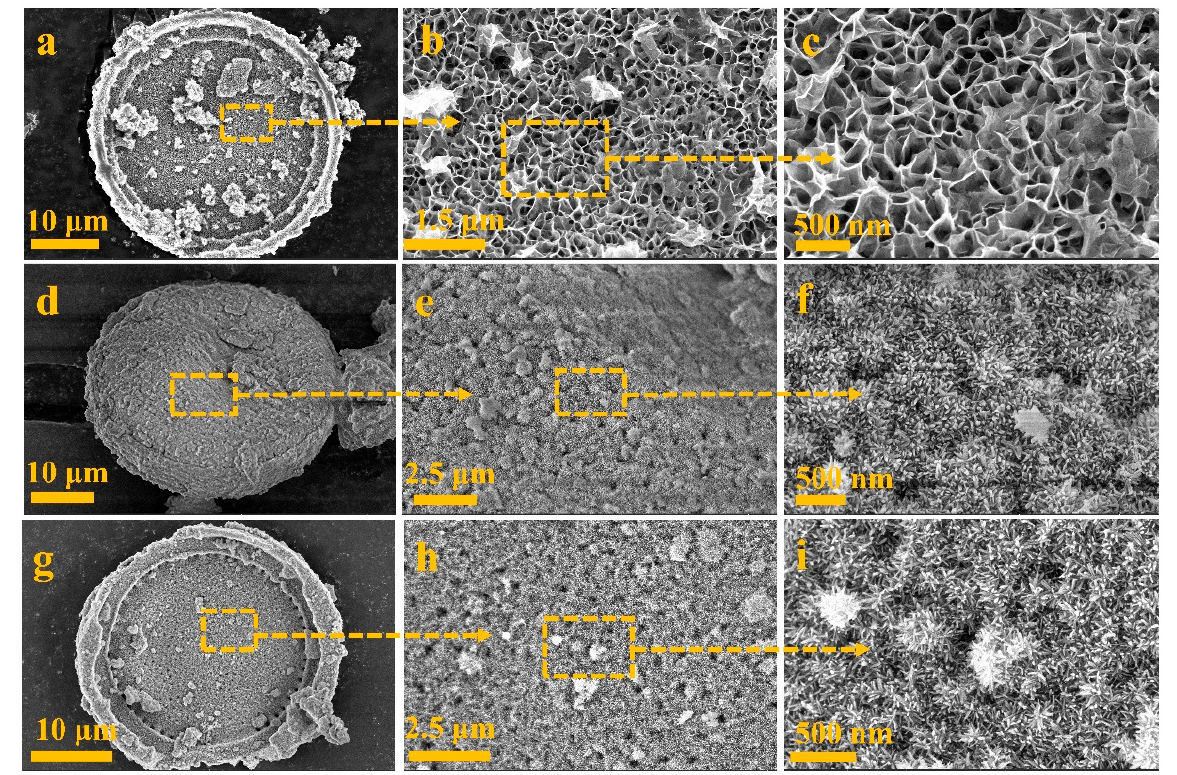
Figure 1. Magnification increases from left to right. SEM images of ( a – c ) MnO 2 @D; ( d – f ) FeOOH@D; ( g – i ) α -Fe 2 O 3 @D.